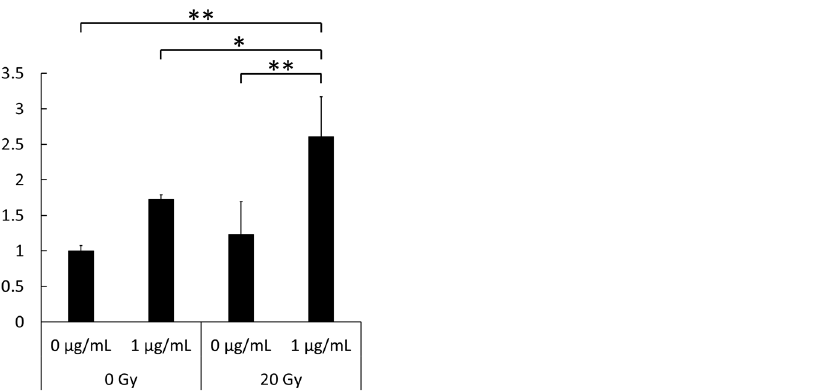
Figure 4. Intracellular accumulation levels of hematoporphyrin dihydrochloride (HpD) in RAW264 macrophages after treatment with lipopolysaccharide (LPS) and X-rays. Cells were exposed to HpD for a total of 6 h. Statistical significance was assessed by Tukey’s test. Data are shown as mean ± standard deviation; n = 4. * p < 0.05, ** p < 0.01.